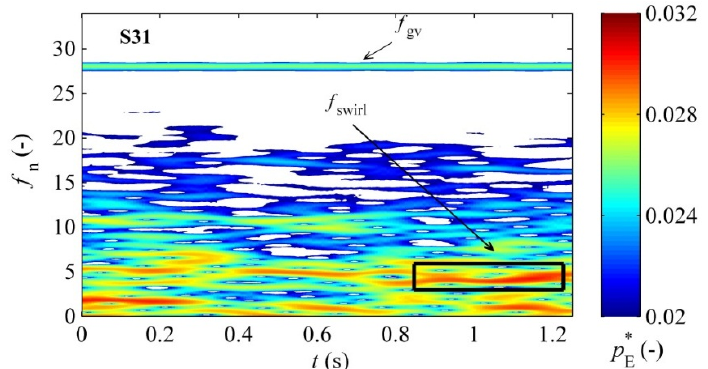
Figure 19. PSD analysis of the numerical point S32 on the blade suction side; f gv corresponds to the frequency of guide vane passing.